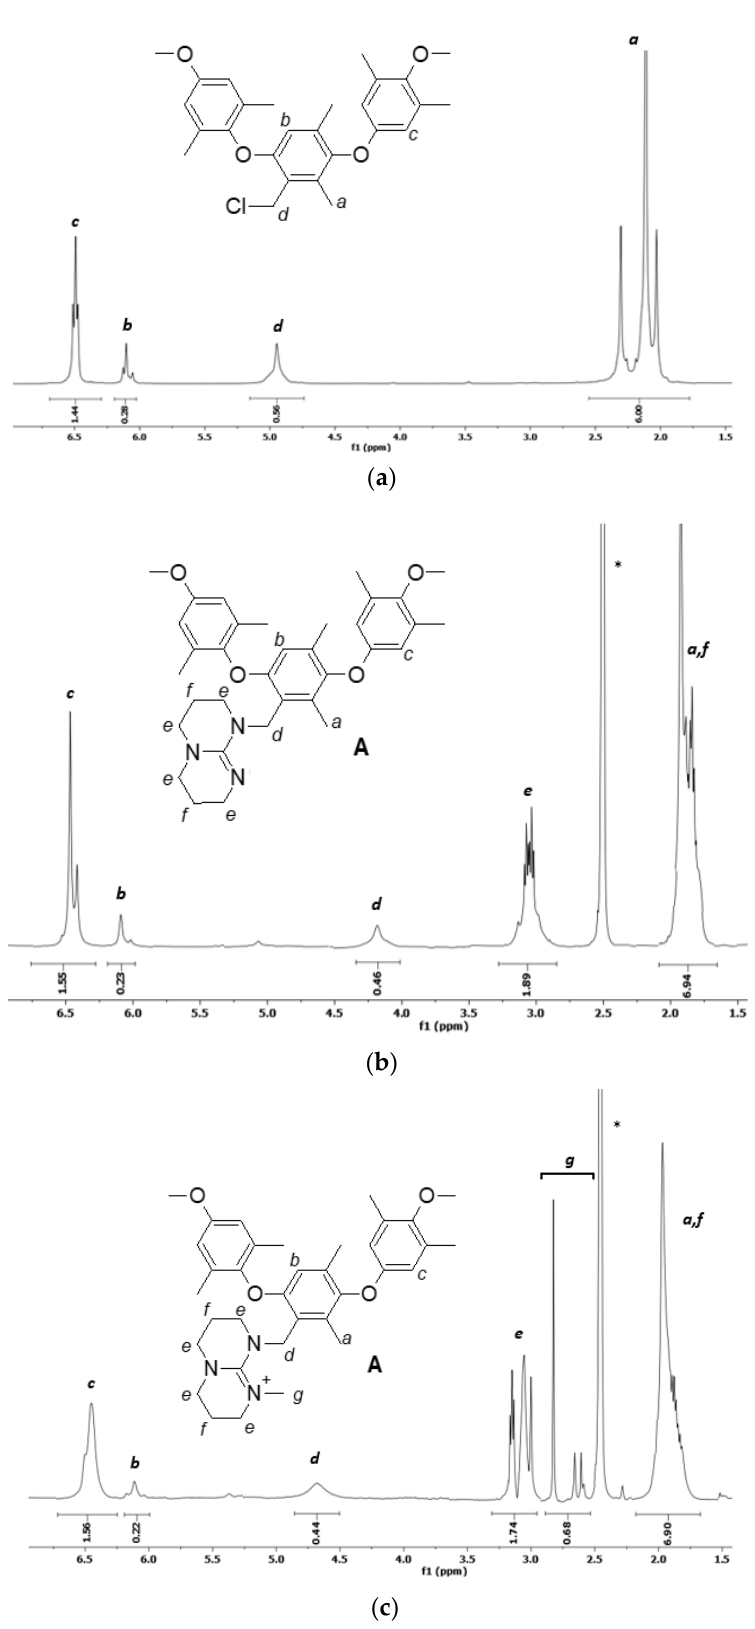
Figure 2. 1 H NMR spectra of ( a ) PPO-CH 2 Cl in CDCl 3 (the solvent is not shown in the figure, 7.27 ppm), ( b ) PPO-TBD and ( c ) PPO-TBD-Me in DMSO (d 6 ). The asterisk indicates the solvent.